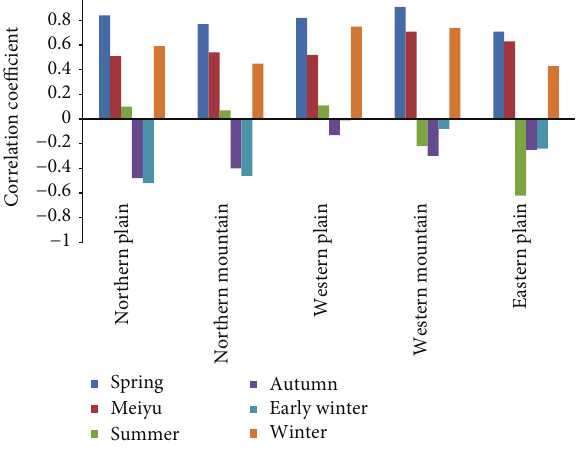
Figure 3: Correlation coefficients between rainfall anomaly and Ni˜no 3.4 at five subareas during canonical El Ni˜no